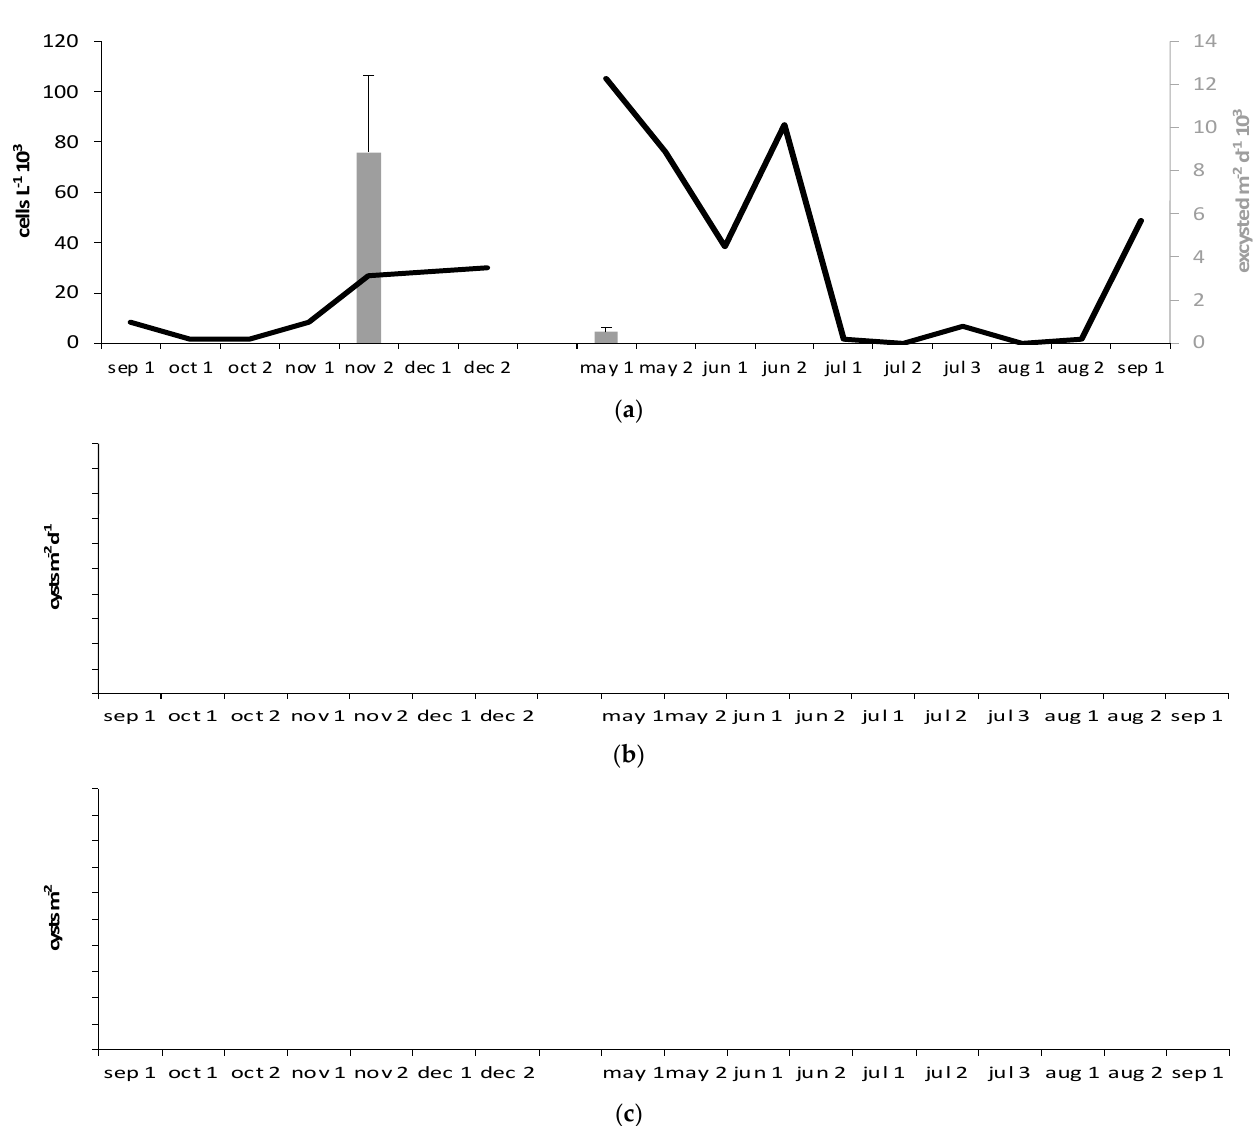
Figure 11. The pelagic-benthic dynamics of Akashiwo sanguinea in the Mar Piccolo of Taranto; ( a ) active cells in the water column, collected with a Niskin bottle at three different depths (black line); active cells (intended as excysted) from the sediment, collected with inverted traps (grey bars); ( b ) cyst fluxes to the bottom; ( c ) full cysts in surface sediment cores.